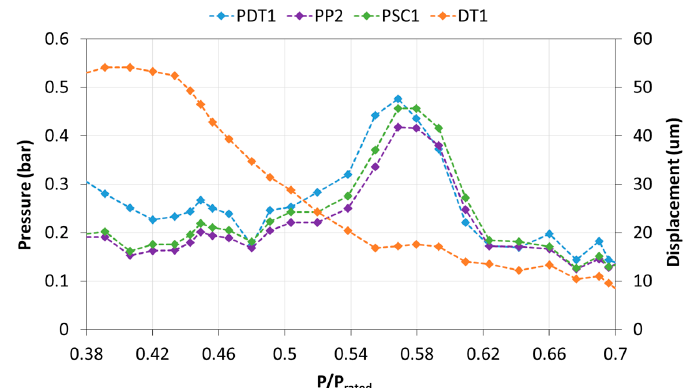
Figure 10. RMS values (0.4 to 2 Hz) of pressure in the draft tube (PDT1), in the spiral casing (PSC1) and in the penstock (PP2) and displacement of the shaft (DT1) for the part load operation.